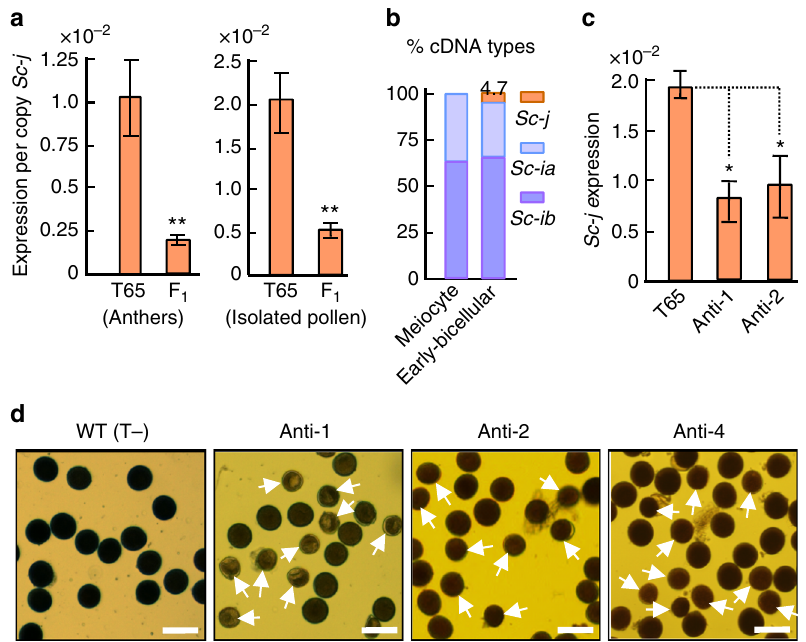
Fig. 3 Functional analysis of Sc-j . a qRT-PCR analysis of relative Sc-j expression levels (using the Sc-j -speci fi c primers P1/P2) in the anthers and isolated pollen (at early-bicellular stage) of the F 1 (T65/E5) and T65, calculated as the ratios of the transcript per copy Sc-j to the transcript of OsActin 1 (two copies), because there is only one Sc-j copy in the F 1 . The data are shown as means ± s.e.m. ( n = 3), and * and ** indicate signi fi cance at P < 0.05 and P < 0.01, respectively, by two-tailed Student ’ s t test (the same for Fig. 3c). b Percentages of cDNA clones from Sc-j , Sc-ia , and Sc-ib ( Sc-ib1 / ib2 ) of the F 1 anthers of two stages indicated. c Expression of Sc-j in the early-bicellular stage anthers of two T 1 (T65 background) plants carrying the hemizygous antisense-transgene of Sc-j . The detected transcript levels in Anti-1 and Anti-2 could be mainly from the pollen grains (~ 50%) without the antisense- transgene. d Semi-sterility of three T 1 plants carrying the hemizygous antisense-transgene. WT (T-), a T 1 segregant without the antisense-transgene.